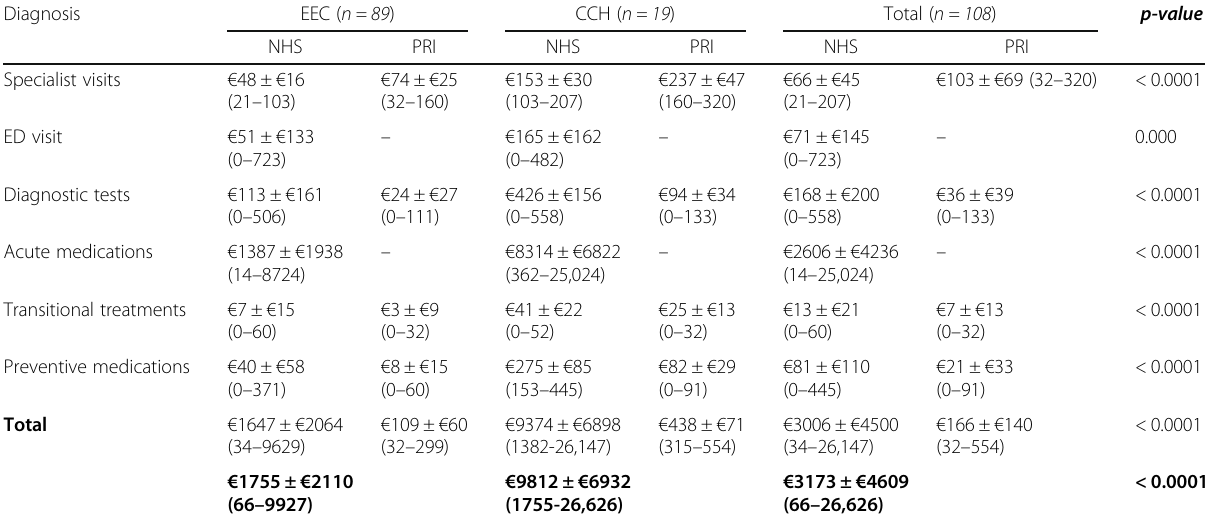
Table 3 Direct costs per CH